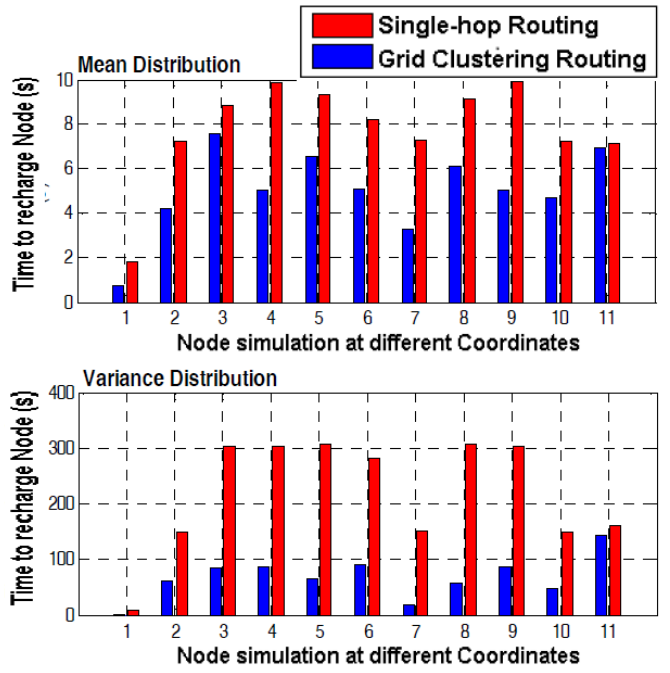
Figure 10. Time needed to recharge the specific node. Future Internet 2017 , 9 , 54